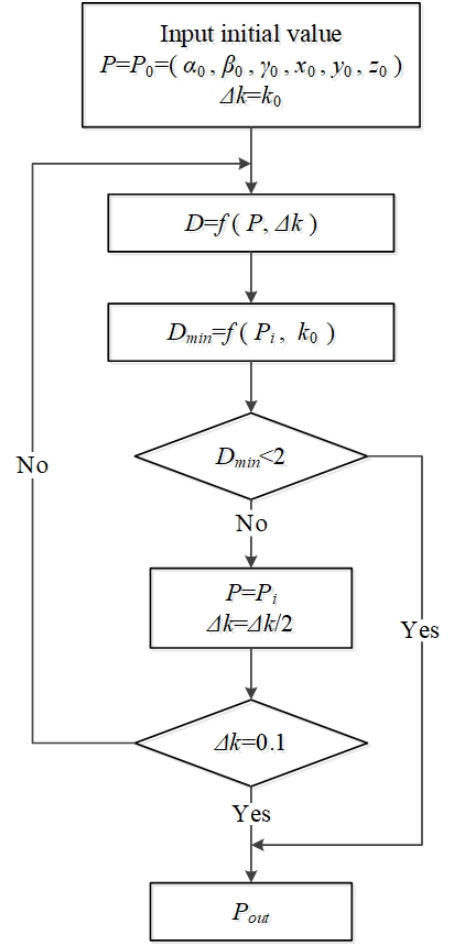
Figure 5. The structural block diagram of the step acceleration process.